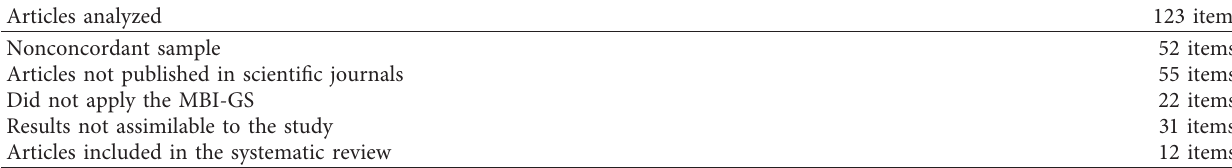
Table 2: Exclusion criteria and article refinement.